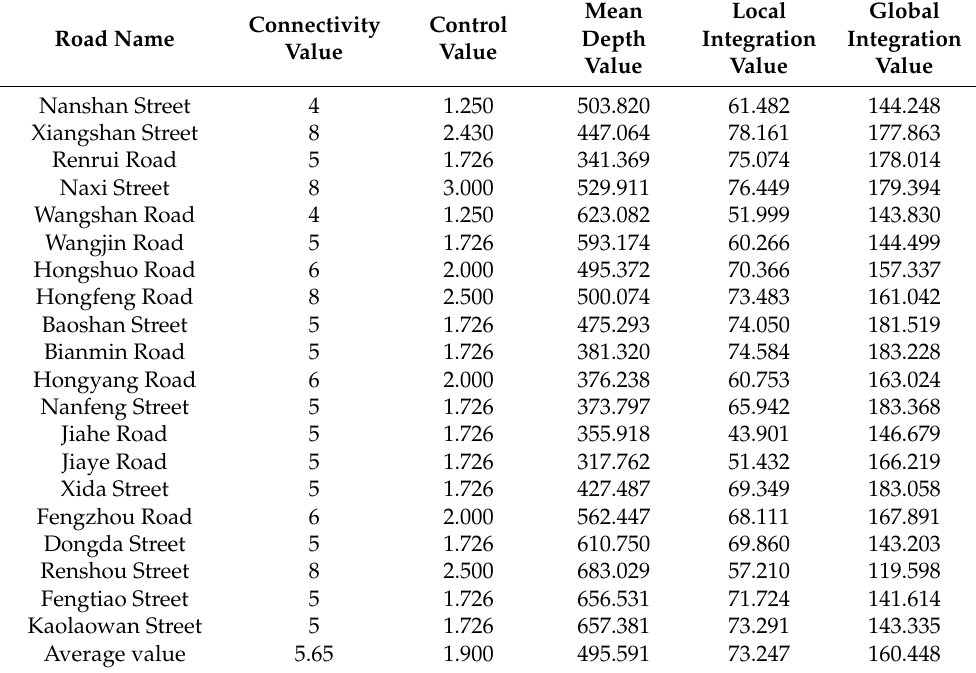
Table 3. Space syntax analysis variables of ancient town area in